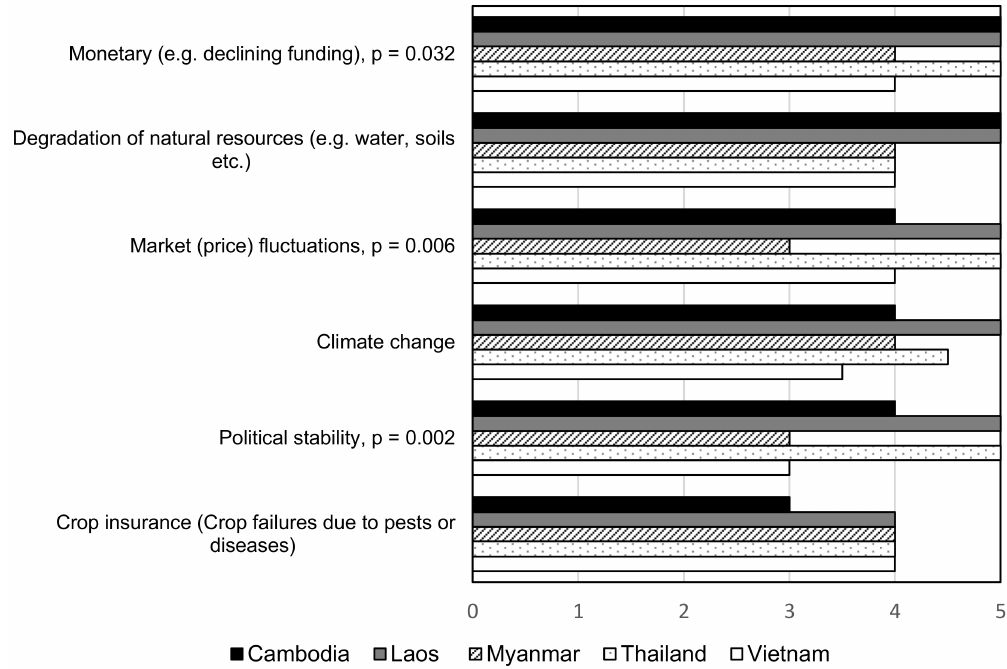
Figure 4. National scores (median) of risk potentials for the regional bioenergy network (1 = unlikely a risk, 5 = likely a risk). Significant differences between all country groups are indicated by the respective p value ( χ 2 (4)). Data source: post workshop survey, authors’ compilation